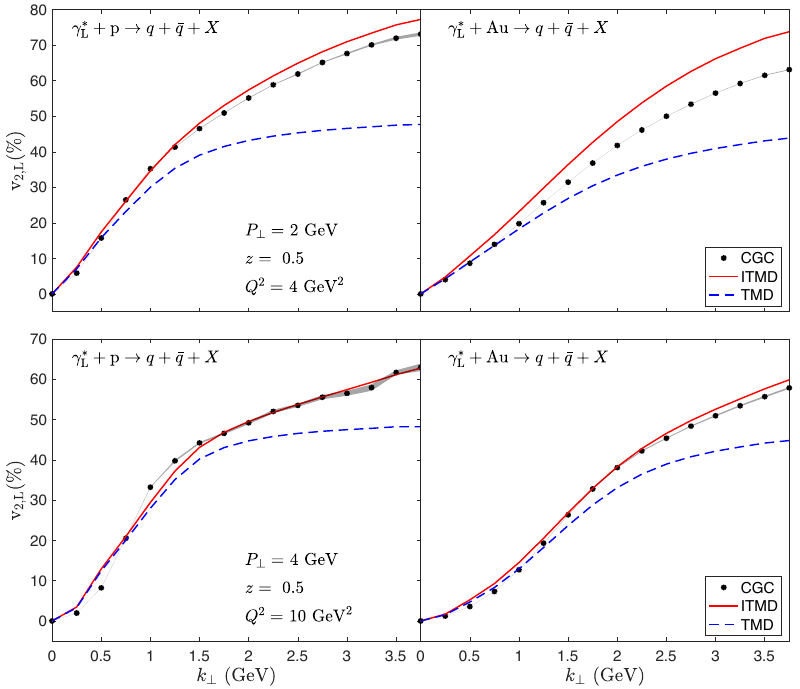
Figure 10 . Elliptic anisotropy v 2 in the angle φ for production of quark anti-quark pair in γ ∗ scattering. The grey band shows the numerical uncertainty of the CGC